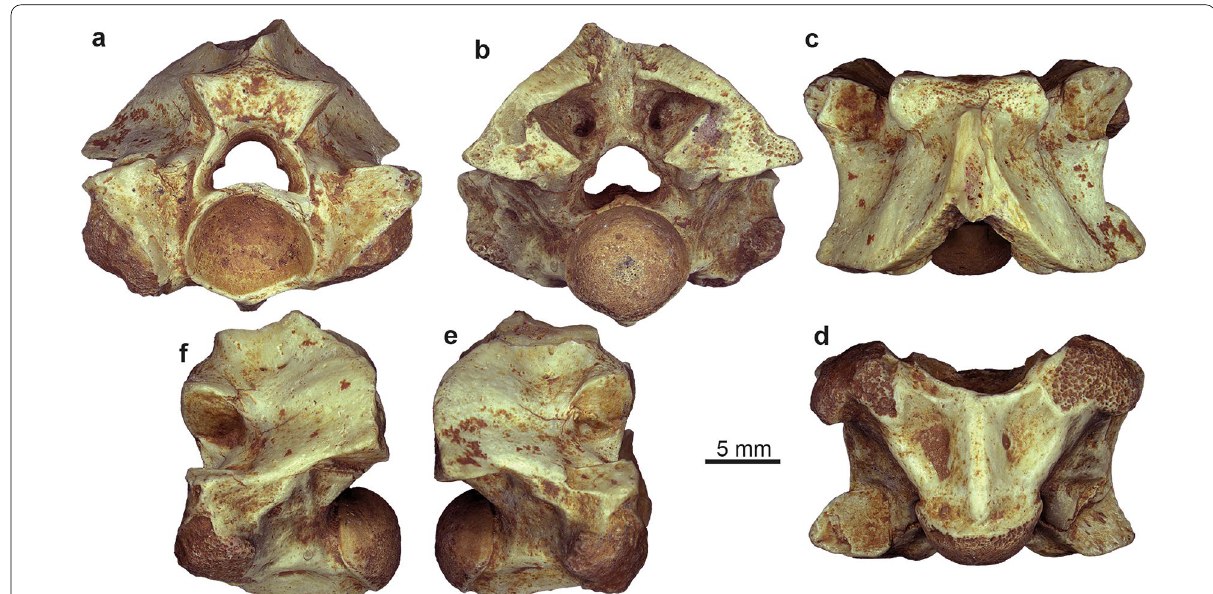
Fig. 13 Palaeopython cadurcensis from an imprecisely known locality in the Phosphorites du Quercy: mid- to posterior trunk vertebra (NHMW 2019/0032/0003) in anterior ( a ), posterior ( b ), dorsal ( c ), ventral ( d ), right lateral ( e ), and left lateral ( f ) views